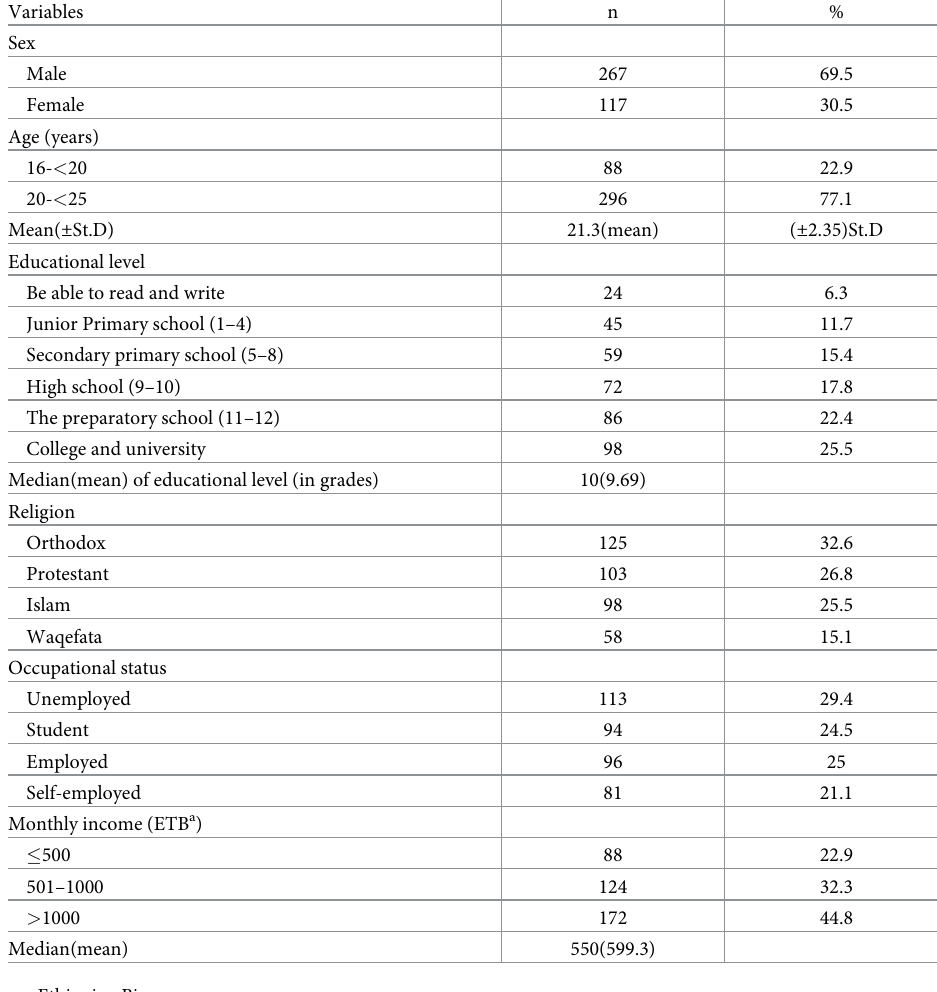
Table 1. Socio-demographic characteristics of youths in OSZSF, 2020 (n =